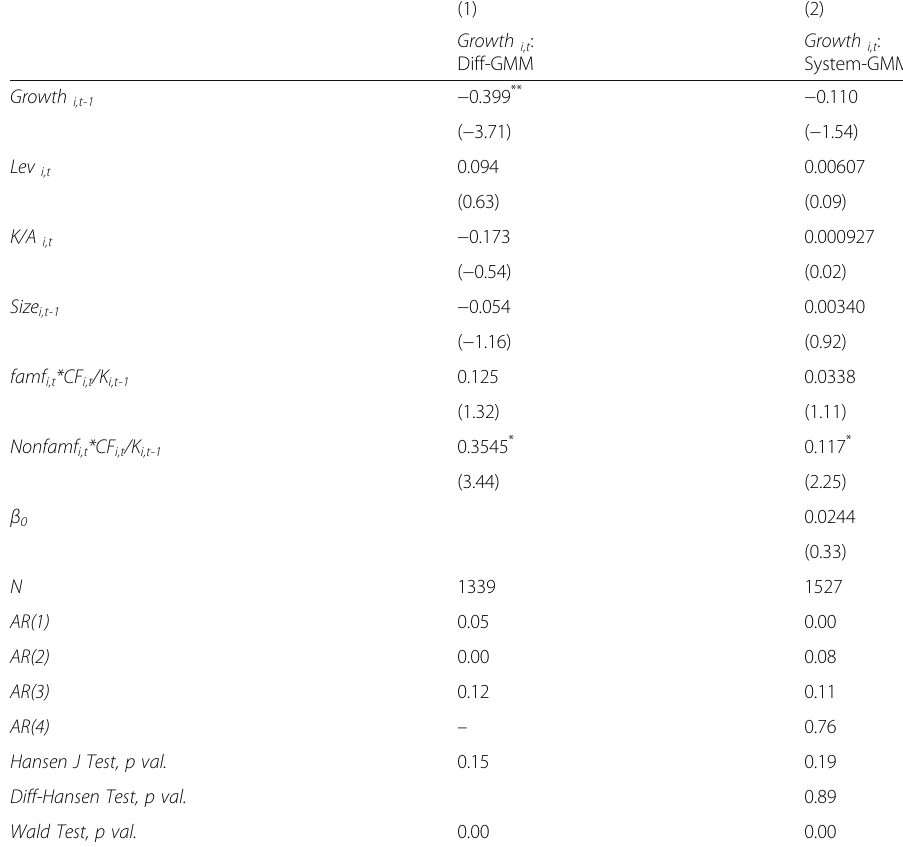
Table 8 System GMM and Differenced GMM results with lagged